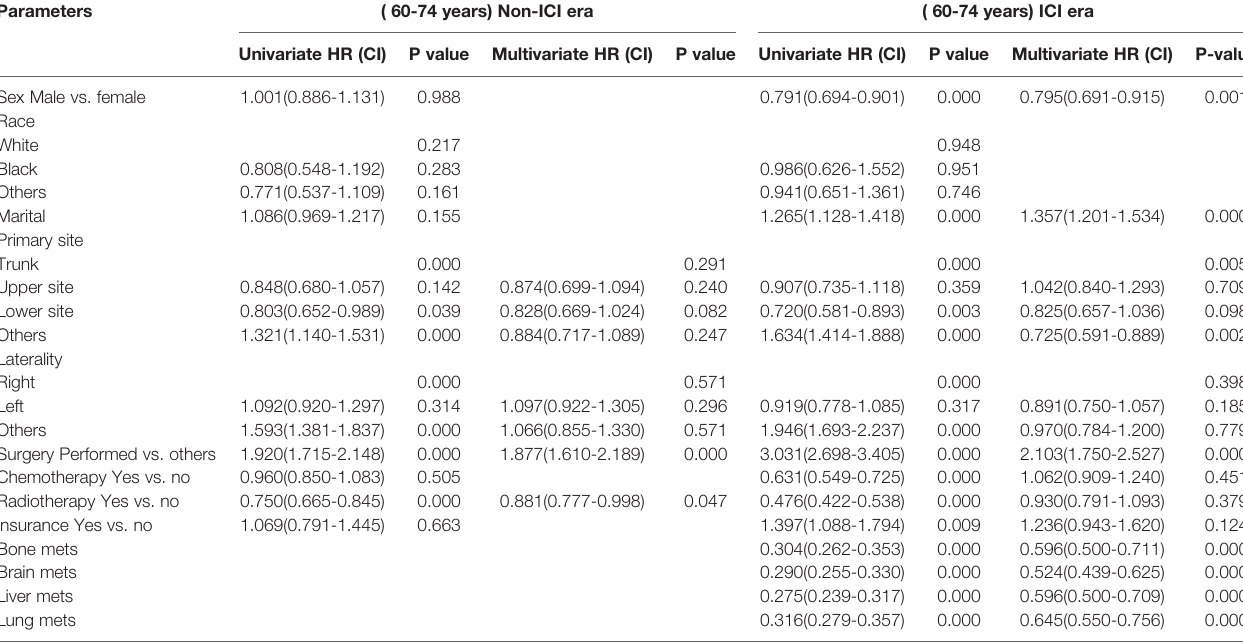
TABLE 3 B. | Univariate and multivariate analysis of factors affecting the survival in non-ICI era and ICI in second age group. Parameters